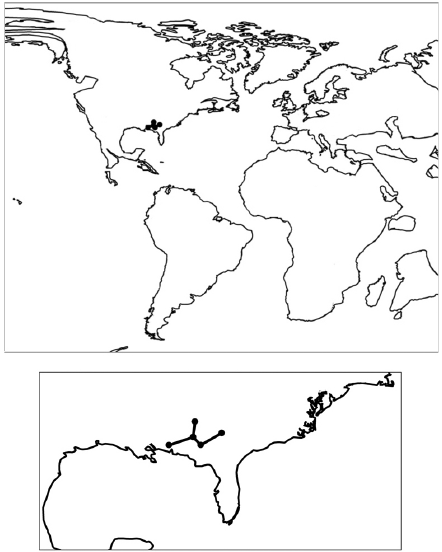
Fig. 11 - Campanian paleogeographic map showing the indi- vidual track of Megalocoelacanthus dobiei , with a zoom of the occurrences below.